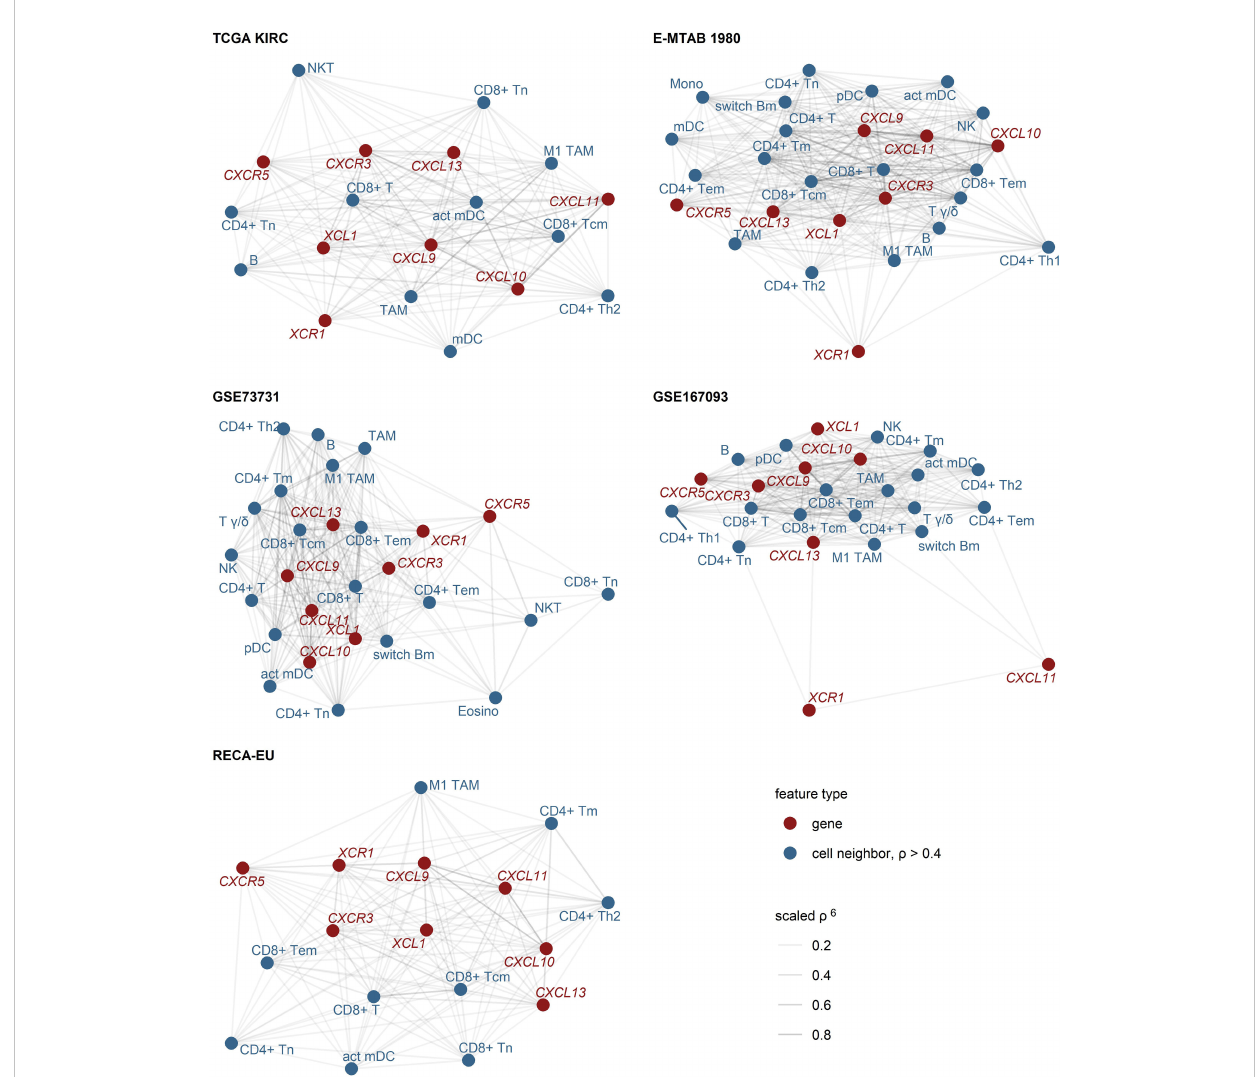
FIGURE 2 Expression of CXCL9/10/11 , CXCL13 , XCL1 and their cognate receptors in RCC samples enriched in CD8 + and CD4 + T cells, activated myeloid DC, TAM and B cells. Pairwise association of the gene expression and xCell non-immune cell in fi ltration estimates was assessed by scaled Spearman ’ s correlation. The genes of interest and the cell types associated with the genes of interest with moderate-to-large strength (correlation coef fi cient r > 0.4) were visualized as network force-directed plots with edge weighting by the scaled Spearman ’ s correlation coef fi cient. CD8 + T, CD8 + T cells, CD4 + T, CD4 + T cells, n, naive; m, memory; em, effector memory; cm, central memory; Th1, T helper cells 1; Th1, T helper cells 1; mDC, myeloid dendritic cells, act mDC, activated mDC; pDC, plasmacytoid dendritic cells; TAM, tumor-associated macrophages; B, B cells, switch Bm, class- switched memory B cells; NK, natural killer cells; NKT, natural killer T cells; T gd , gd T cells; Mono, monocytes; Eosino,